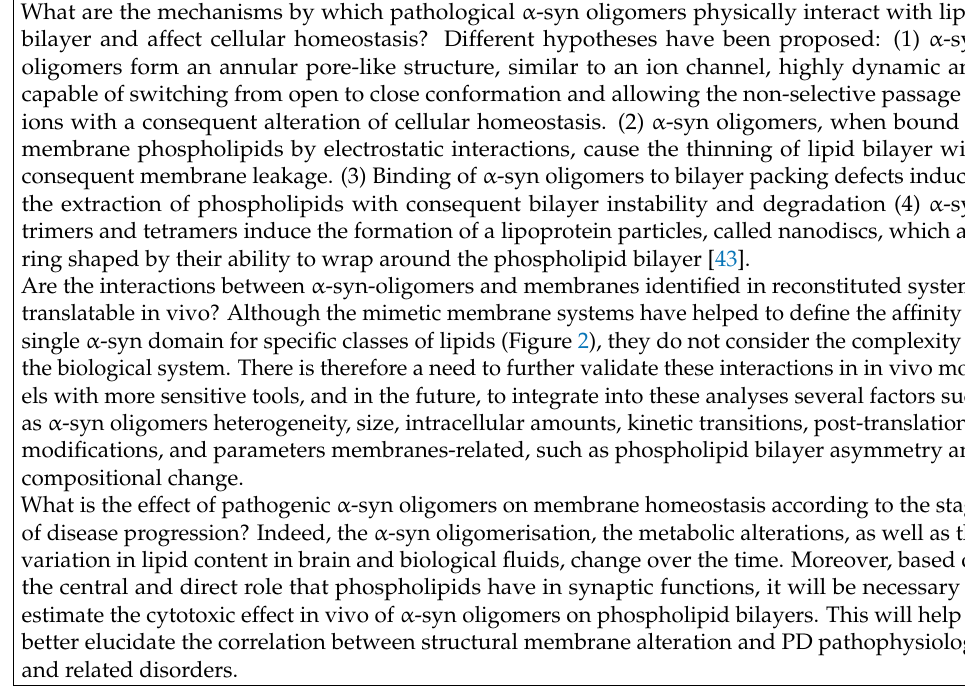
Table 6. Summary table on α -synuclein ( α -syn) lipid interactions and synaptic dysfunctions in different models. The table provides the main information on α -syn wild type and PD-associated modifications (first column) and their effect on membrane lipids interaction (second column) that has been extensively described in Section 2. The mains functional effects of α -syn on the different steps of exocytosis are also described, highlighting the role of α -syn on the regulation of docking vesicles (third column, explained in the Section 3.1), fusion pore (fourth column, described in Section 3.2), exocytosis (fifth column, Sections 3.3 and 3.4), and vesicle recycling (sixth column, Section 3.5). Type of α